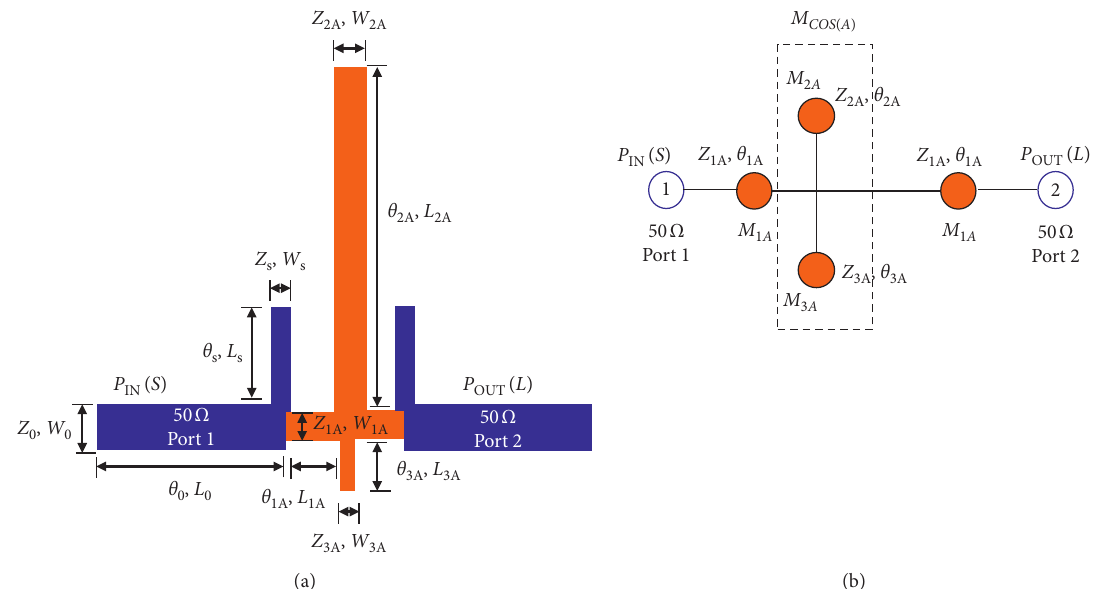
Figure 2: (a) The COS resonator structure and (b) the ABCD matrix structure for the COS